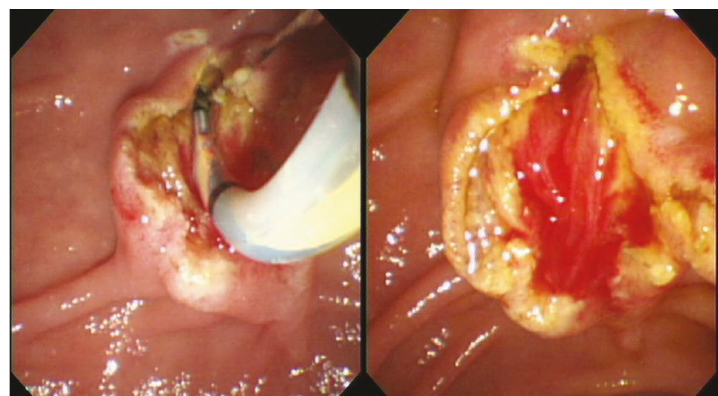
Figure 1: Complete endoscopic sphincterotomy was